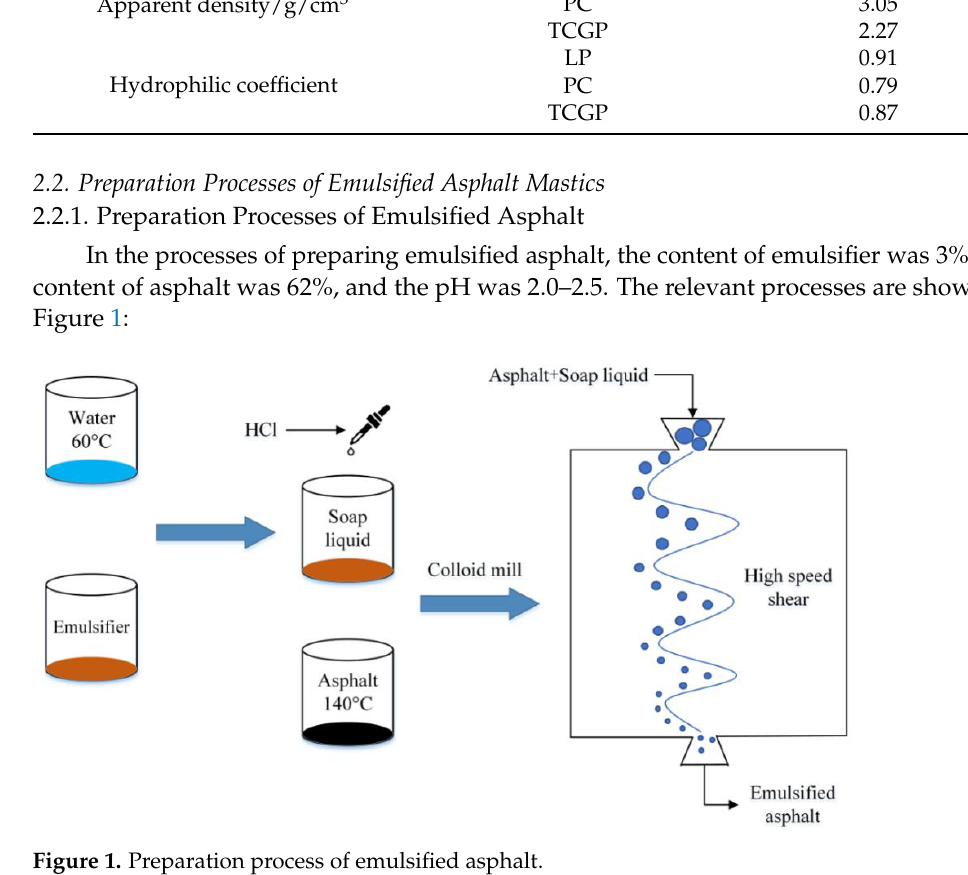
Figure 1. Preparation process of emulsified asphalt.